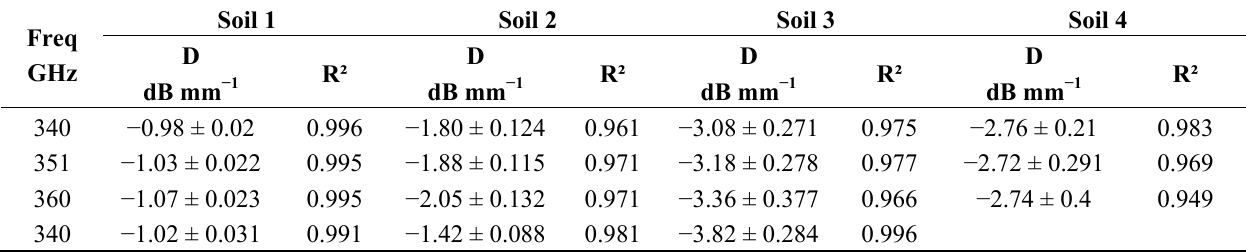
Table 4. Absorption coefficient estimation with linear